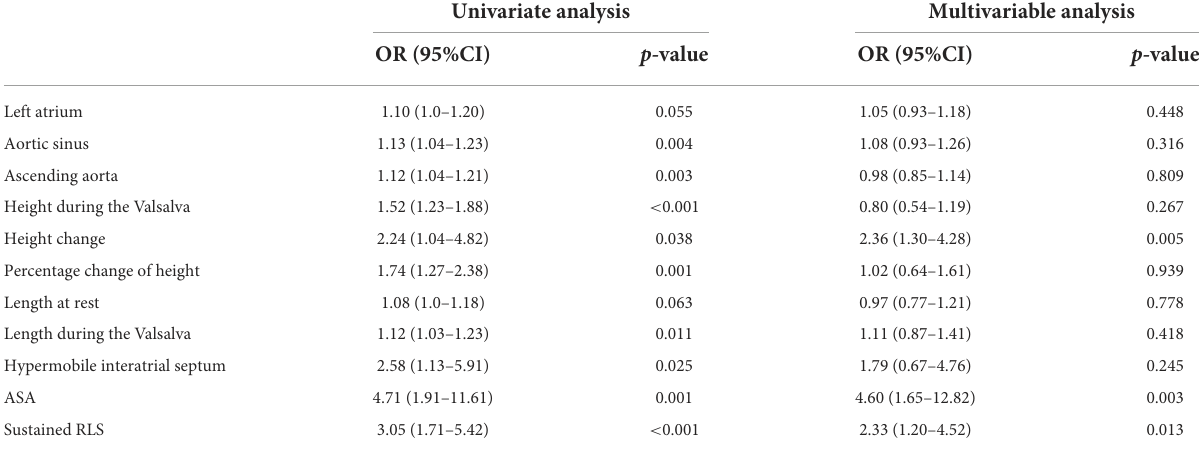
TABLE 3 Univariate and multivariable regression logistic analyses for selection of echocardiographic PFO characteristics associated with stroke.